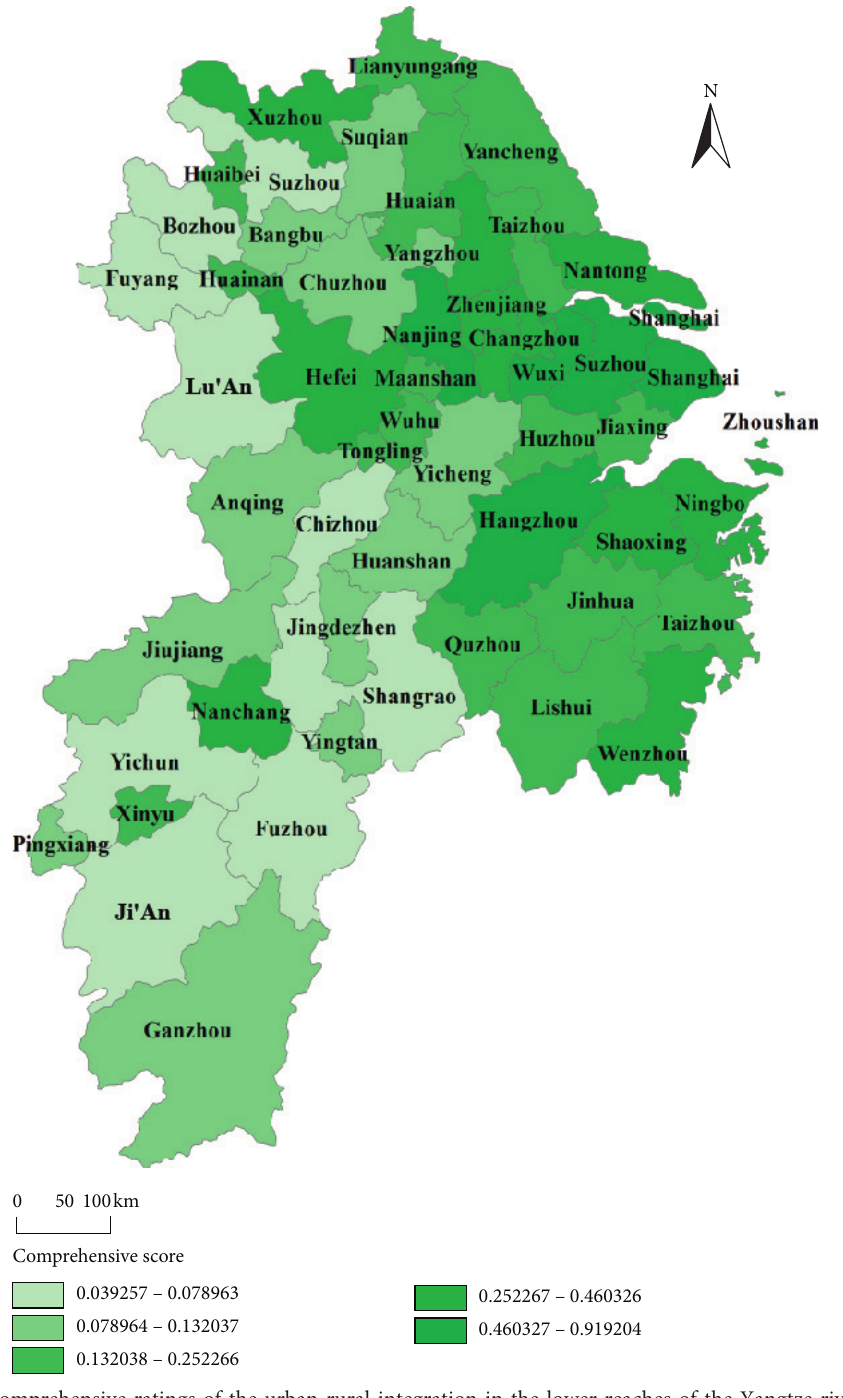
Figure 5: Comprehensive ratings of the urban-rural integration in the lower reaches of the Yangtze river in